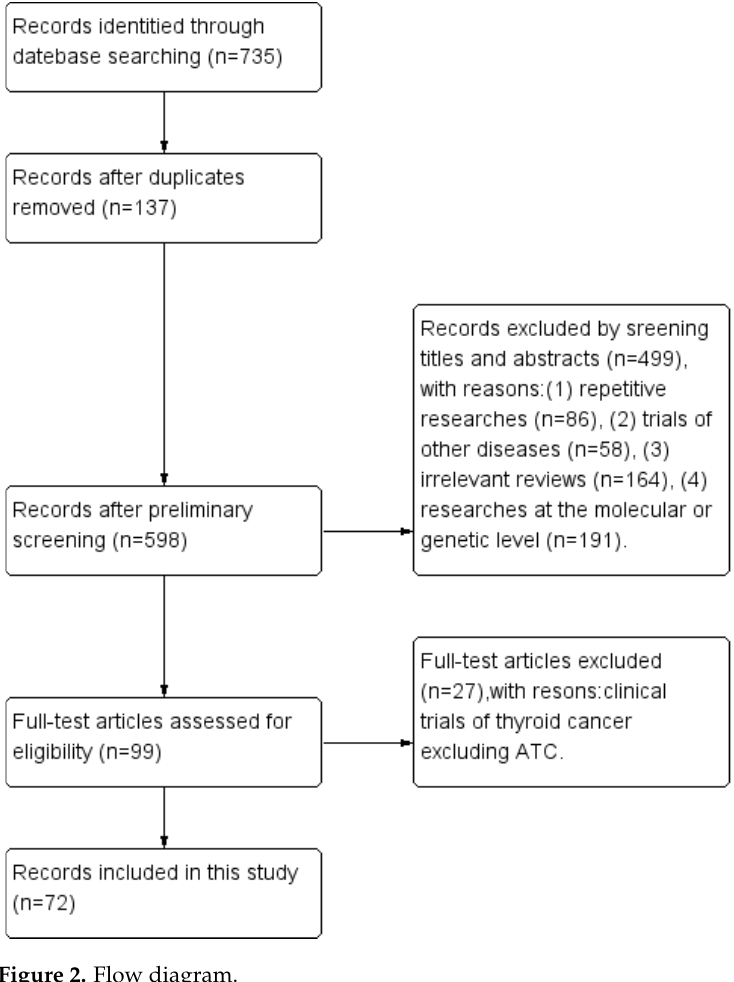
Figure 2. Flow diagram.